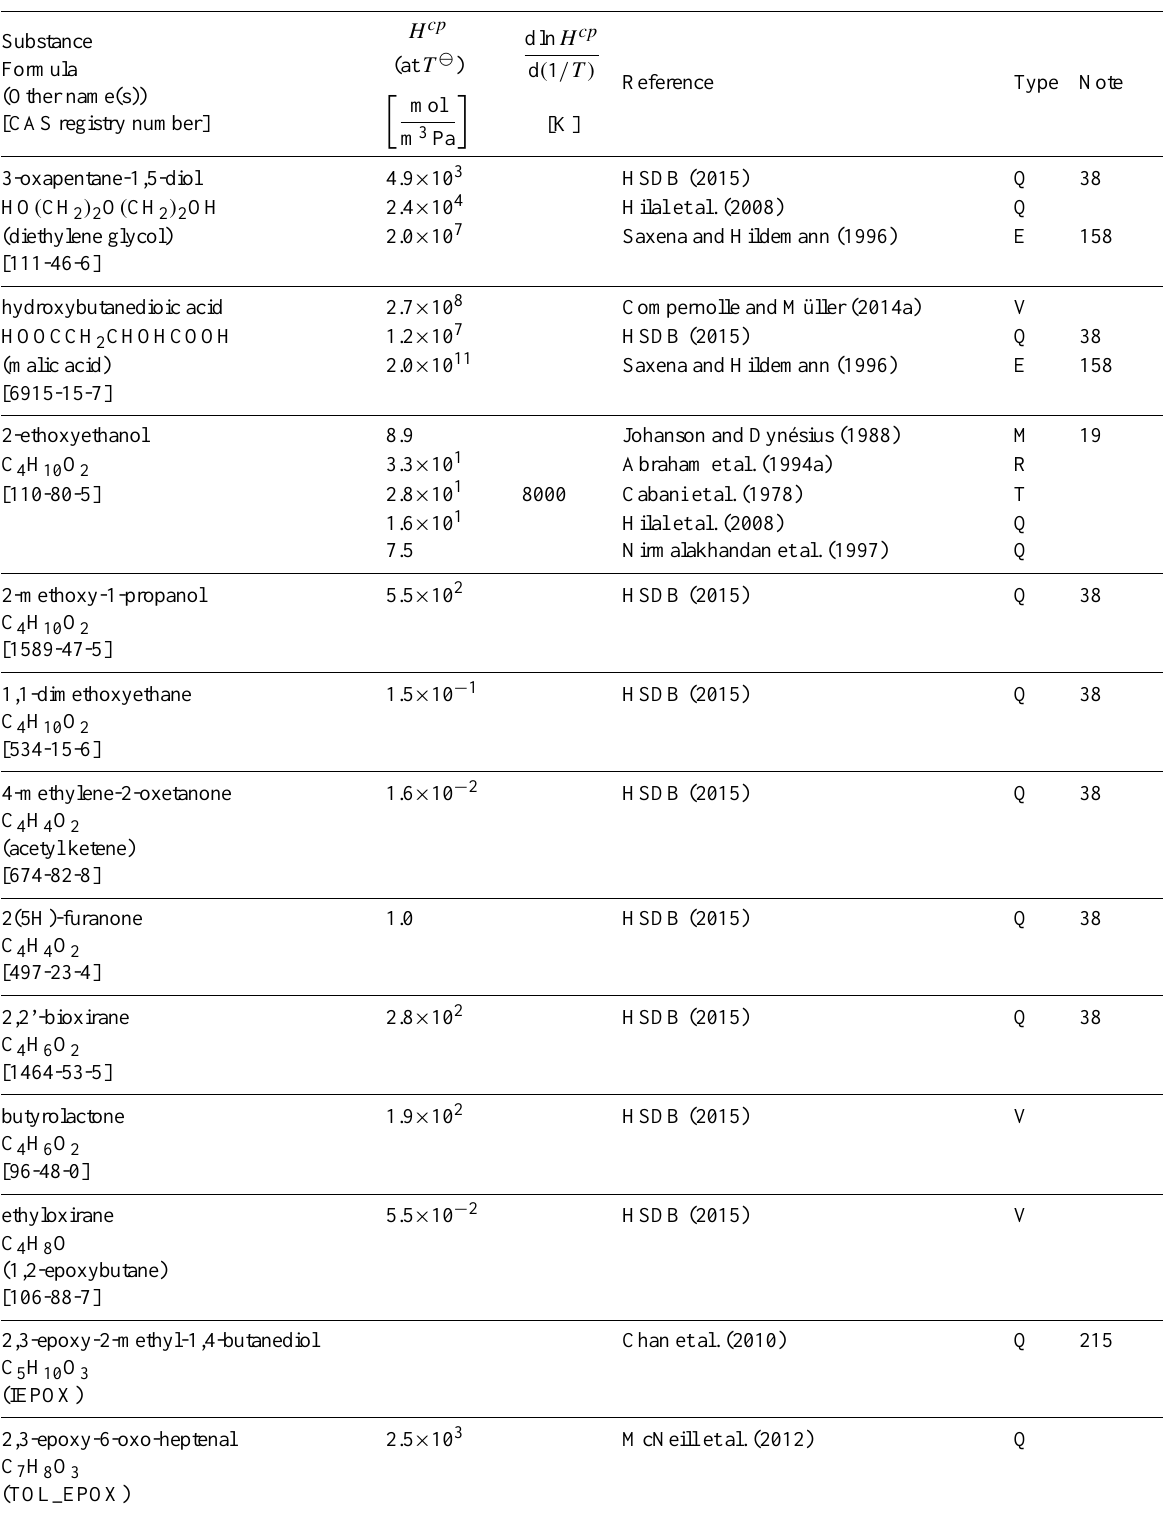
Table 6: Henry’s law constants for water as solvent